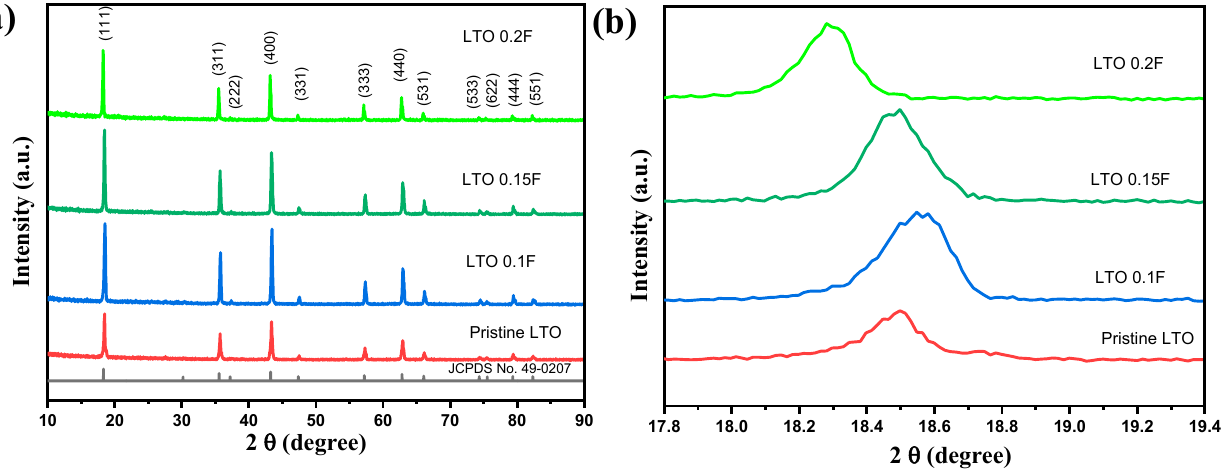
Figure 1. ( a ) XRD pattern of LTO with doping variation F and ( b ) magnified (111) peaks of LTO and F-doped LTO at a temperature of 700 °C.